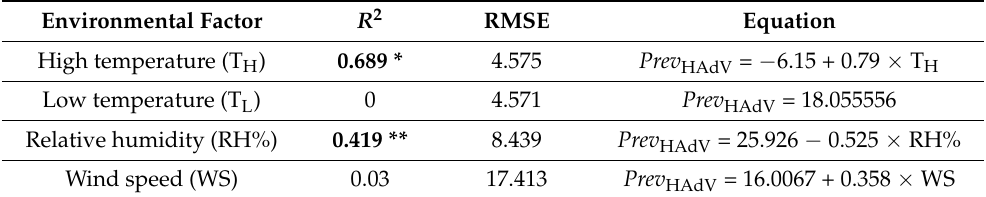
Figure 5. Temperature variation influence on the HAdV prevalence in wastewater samples. “Temp Low” refers to the average low temperature and “Temp High” refers to the average high tempera- ture.